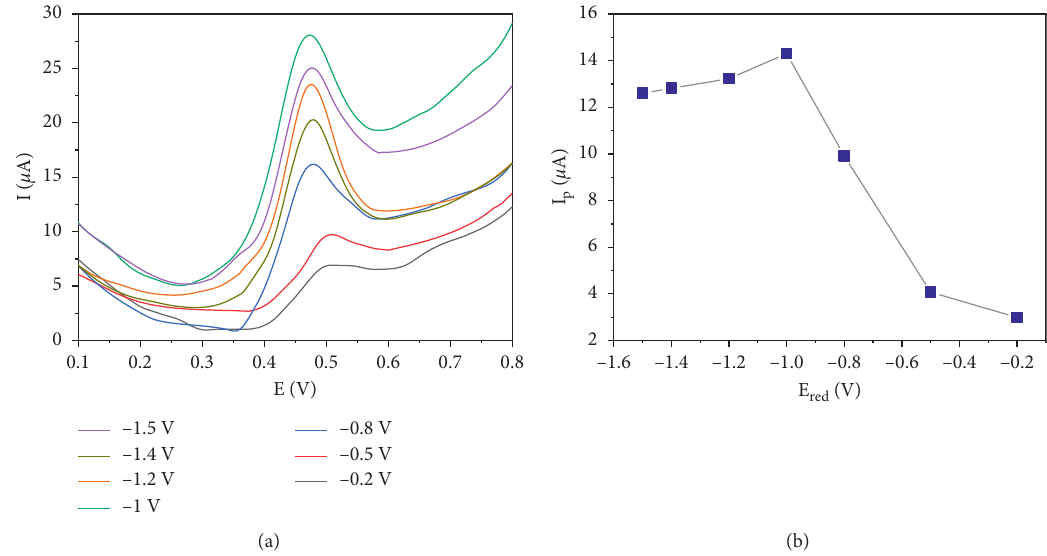
Figure 5: SWVs of RGOnS electrodes prepared at different E E red